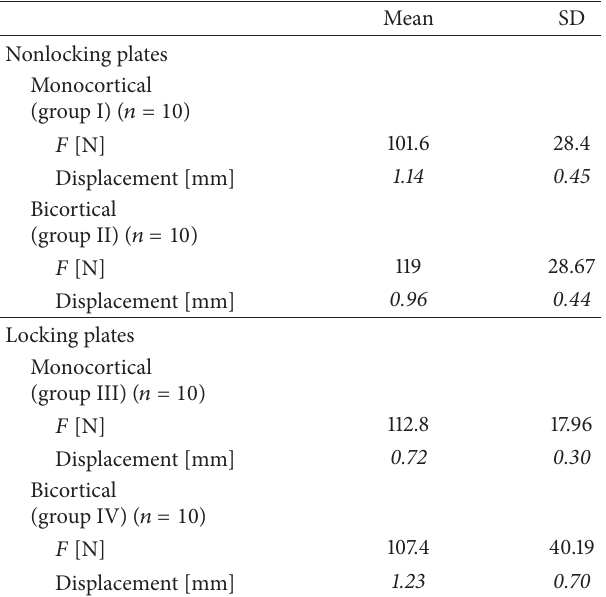
Table 1: Mean load ( 𝐹 ) applied during cyclic testing and displace- ment measured for the locking and nonlocking plates.